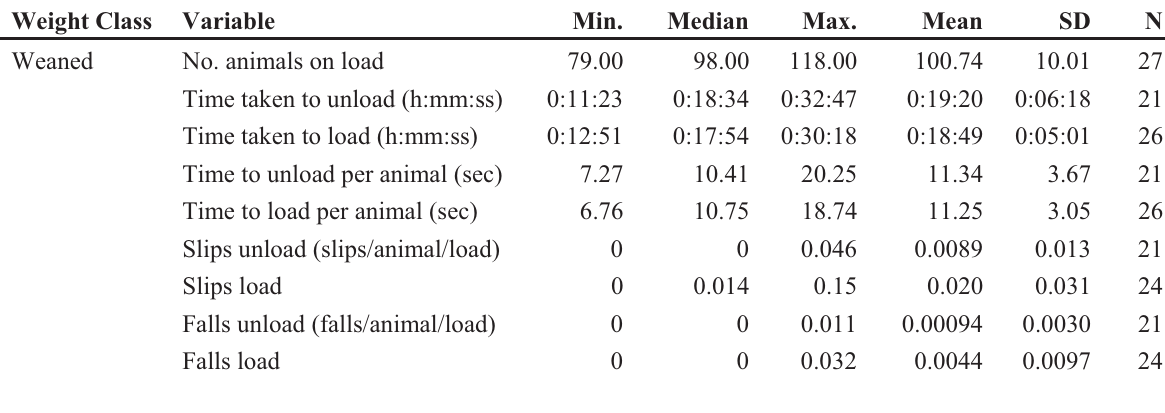
Table 4. Continuous variables by weight class of loads stopping for feed, water and rest near Thunder Bay,